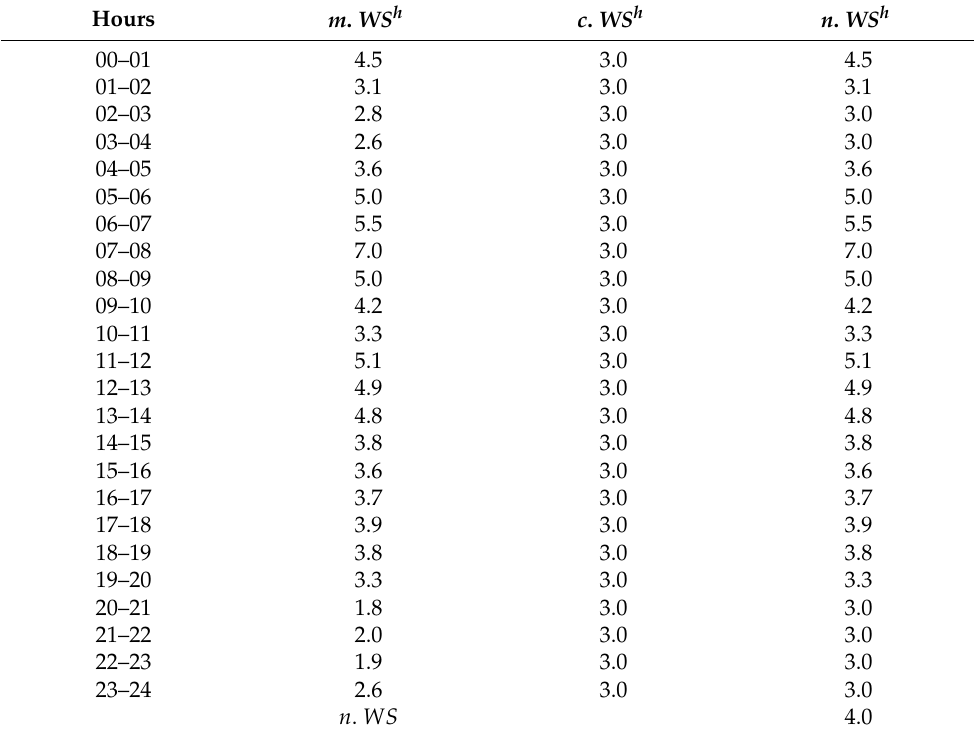
Table 4. Required hourly number of workstations ( n . WS h ) for Yeosu VTS.